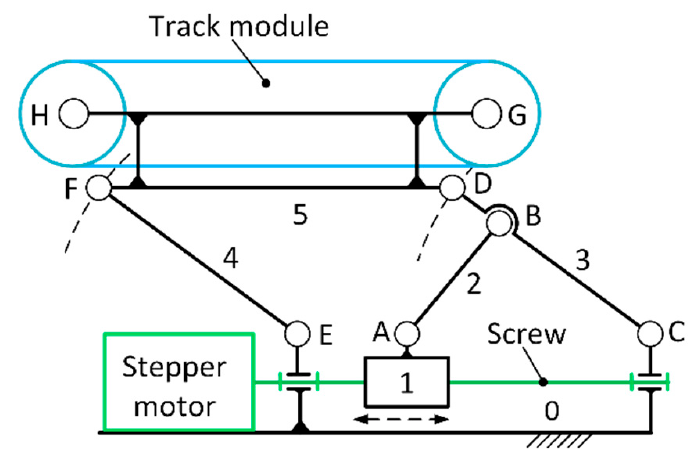
Figure 18. Active adapting mechanism with track module. The robot is adapted to different diameters by moving slider 1 by means of a ball screw driven by a stepper motor. The adapting mechanism is equipped with a force sensor for active control of the wall pressing force. The mathematical model that describes the relationship between the pressing force, the geometry of the mechanism and the torque developed by the stepper motor is presented in [55]. The total length of the robot is 380 mm, and it can inspect straight curved or inclined pipes with a diameter between 220 and 320 mm.